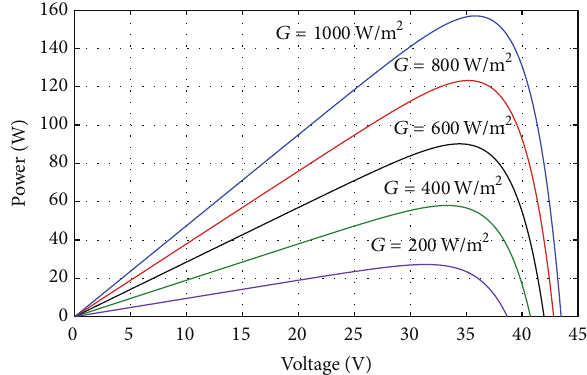
Figure 1: PV module voltage-power at different irradiance levels.